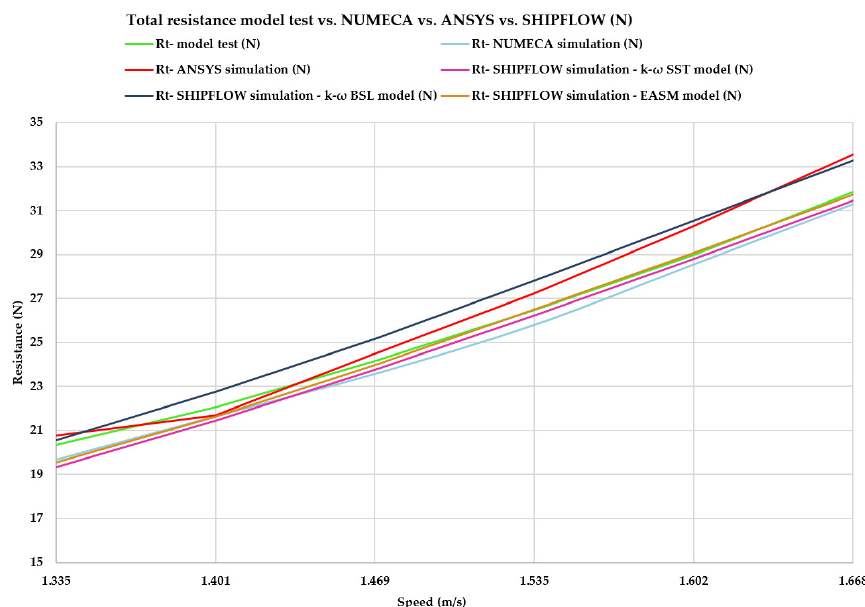
Figure 5. Comparison of total resistance between NUMECA, ANSYS and SHIPFLOW simulations.